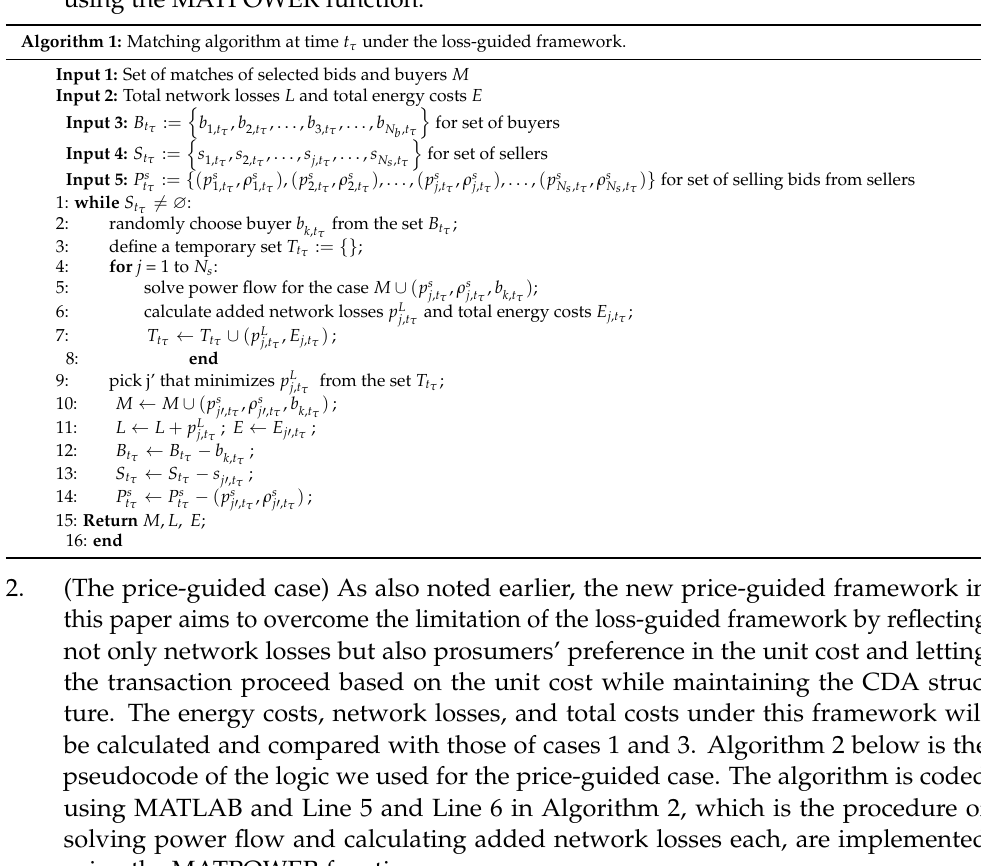
Algorithm 1: Matching algorithm at time t τ under the loss-guided framework.